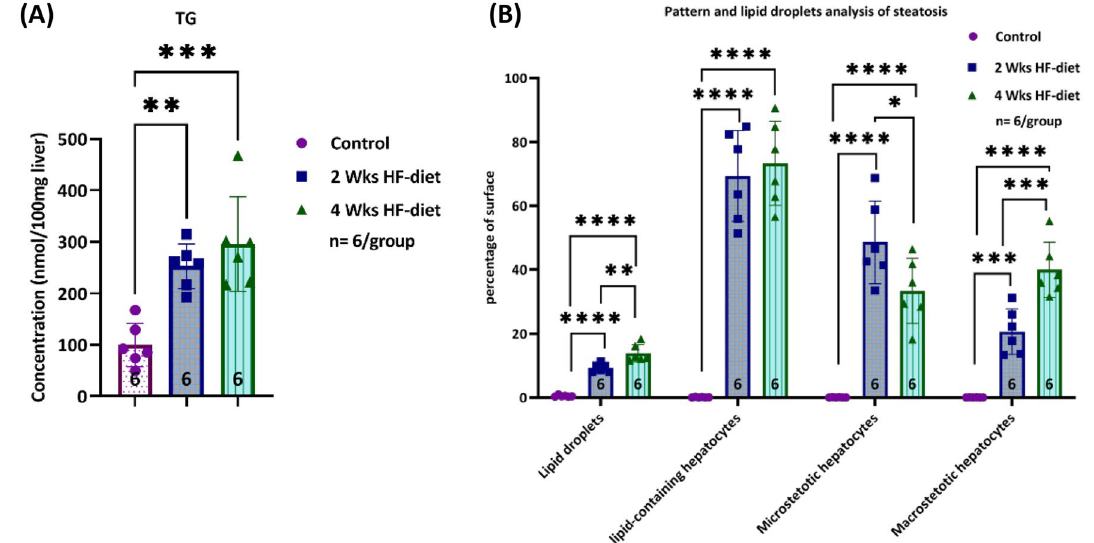
Figure 1. Severity of hepatic steatosis. ( A ) Total triglyceride depending on diet. Total triglyceride measurement showed significantly higher levels in the HF-diet groups compared to control, but no differences between the groups subjected to two respectively four weeks of HF-diet; ( B ) Lipid droplets, lipid-containing hepatocytes, microsteatotic hepatocytes, and macrosteatotic hepatocytes depending on diet. Image analysis using different algorithms detected specific differences in severity when subjecting animals either to 2 or 4 weeks of feeding the special diet. Lipid droplet analysis revealed a significantly higher surface covered by the droplets. Pattern analysis assessing micro-and macrovesicular steatosis separately revealed a strikingly and significantly larger surface covered by microvesicular steatotic hepatocytes after two weeks of feeding in contrast to the significantly larger surface covered by macrovesicular steatotic hepatocytes after four weeks of feeding. The total surface covered by steatotic hepatocytes was similar in both groups (*significance level < 0.05, **significance level <